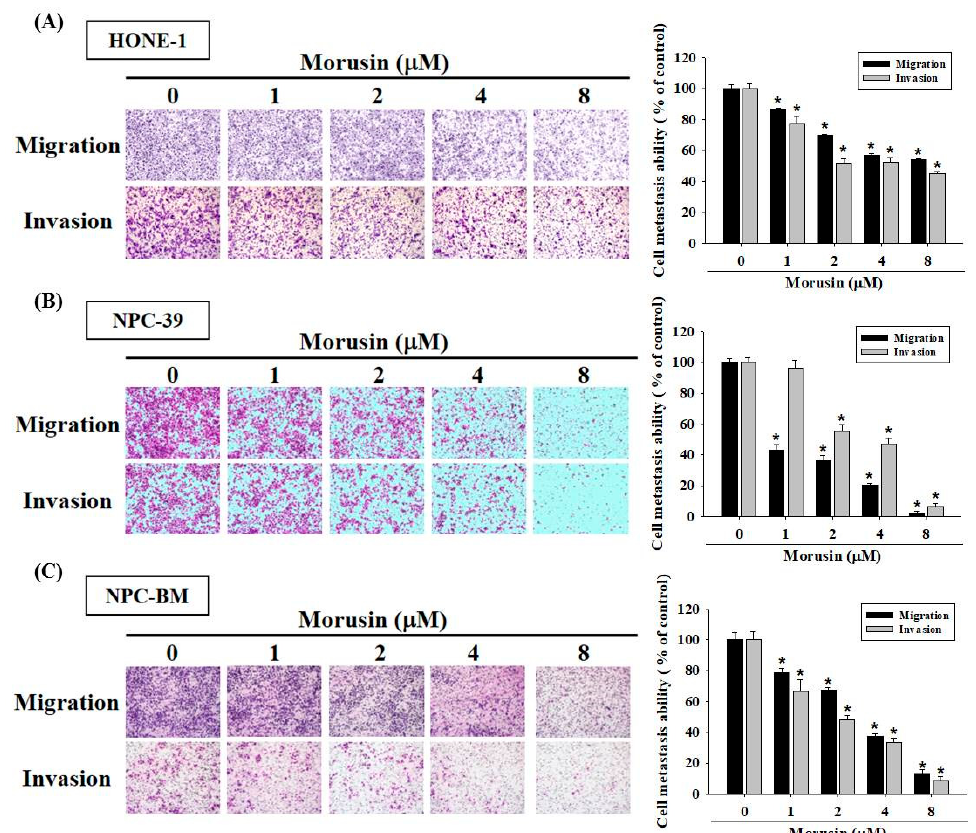
Figure 3. Morusin suppresses the cell migration and invasion of NPC cells. ( A ) HONE-1; ( B ) NPC-39; and ( C ) NPC-BM cells were pretreated with indicated concentrations of morusin. Cell migration and invasion were assayed at 24 h after seeding in a modified Boyden chamber with and without Matrigel coating, respectively. The number of cells was counted using a microscope at 100× magnification. Quantitative data are shown in the right panel. * p < 0.05 as compared with morusin-untreated controls.